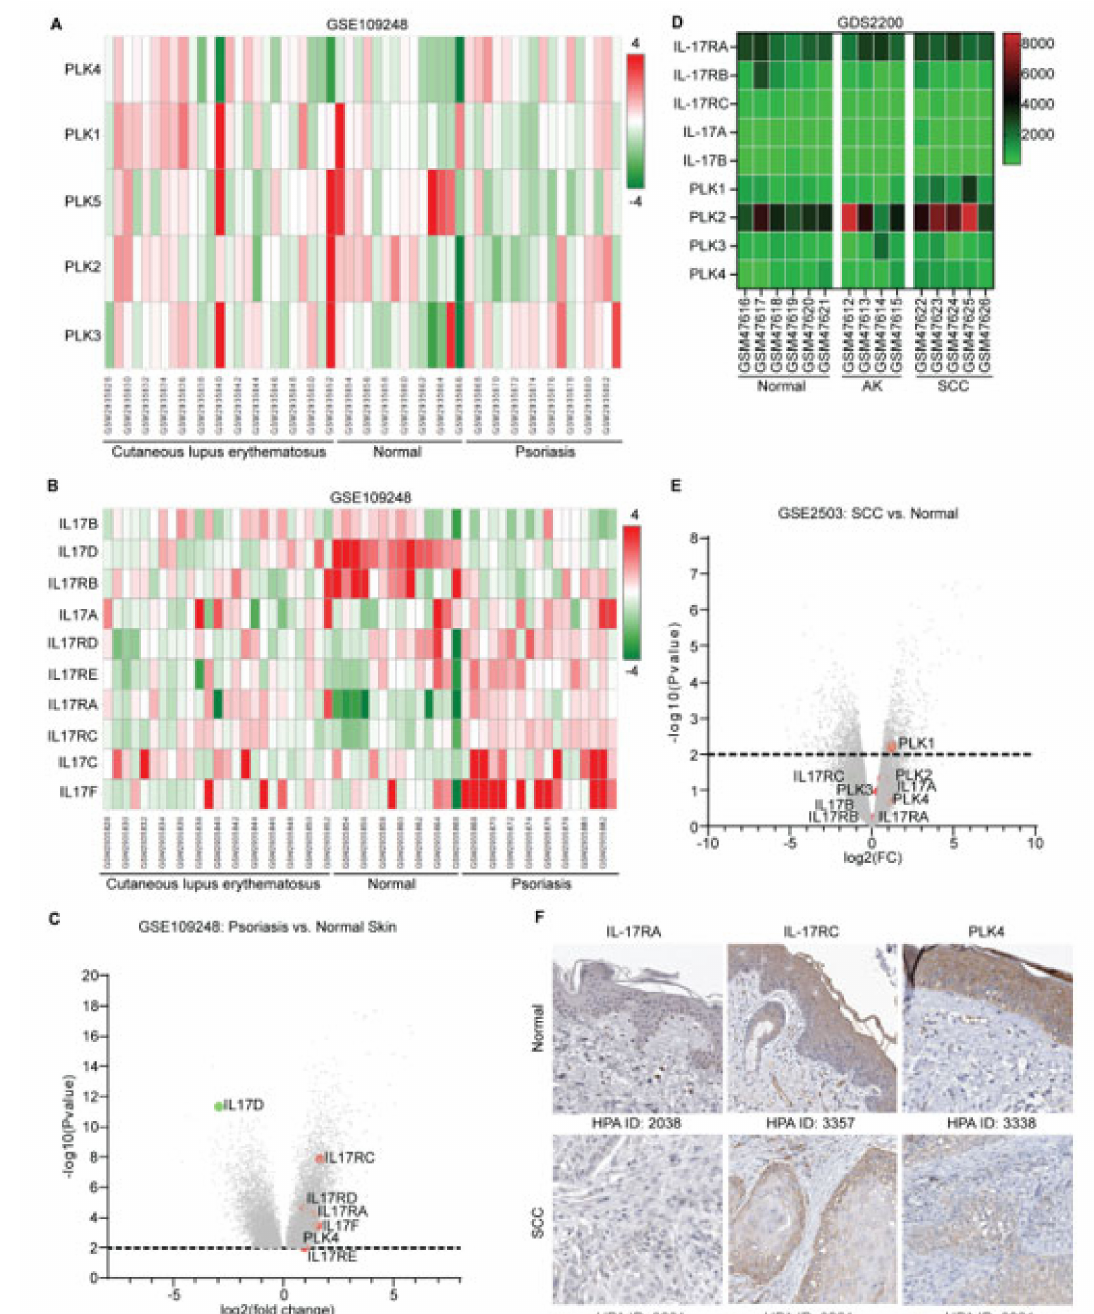
Figure 1. Expression pattern of IL17 and PLK family members in skin cancer and autoimmune diseases. ( A , B ) Original data of GSE109248 were analyzed using the OmicSoft platform. The heatmap shows the expression patterns of PLK family members among normal skin, cutaneous lupus erythematosus, and psoriasis. ( C ) The GEO2R tool was applied to differentially determine the expressed genes ( p value ≤ 0.01) between psoriasis and normal skin. ( D ) The heatmap shows expression patterns of IL17 family members and PLK family members among normal skin, actinic keratosis (AK), and squamous cell carcinoma (SCC) of skin. Data were downloaded from GDS2200 database. ( E ) The volcano plot demonstrates significant genes between SCC and normal skin. Data were downloaded from GSE2503. ( F ) Immunohistochemical staining of human tissues from The Human Protein Atlas (HPA, https://www.proteinatlas.org/, accessed on 12 July 2022) shows expression patterns of IL17RA, IL17RC, and PLK4 between normal skin and